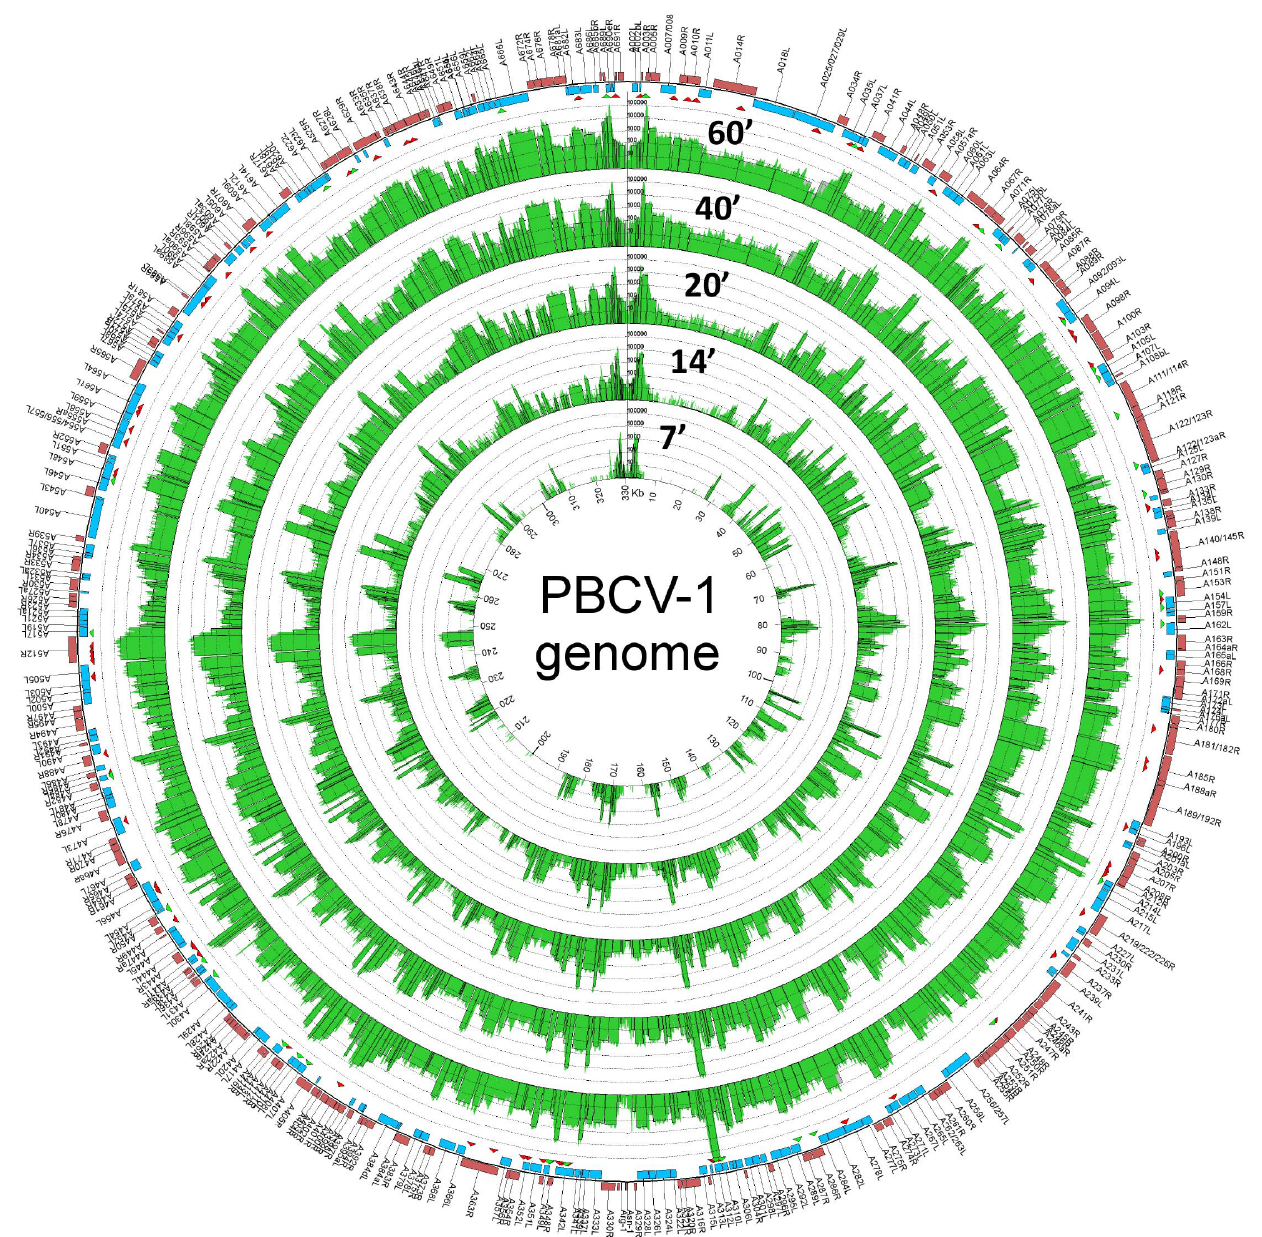
Figure 2. Mapping of the PBCV-1 transcriptome. PBCV-1 genes on the forward and reverse strands are depicted by red and blue boxes respectively. The green curves in the interior concentric circles represent the normalized read coverage for each time point (7, 14, 20, 40, and 60 min p.i.) of the experiment in logarithmic scale (base 10). Open boxes are superimposed onto the read coverage curves to show calculated MRPN values for each gene. Below the outer circle, red and green triangles indicate the location of predicted splice events and polyadenylation cleavage site, respectively. Note: the PBCV-1 genome is a linear molecule with inverted repeats and closed hairpin ends that is depicted as a circle. The two ends are at the 12 o’clock